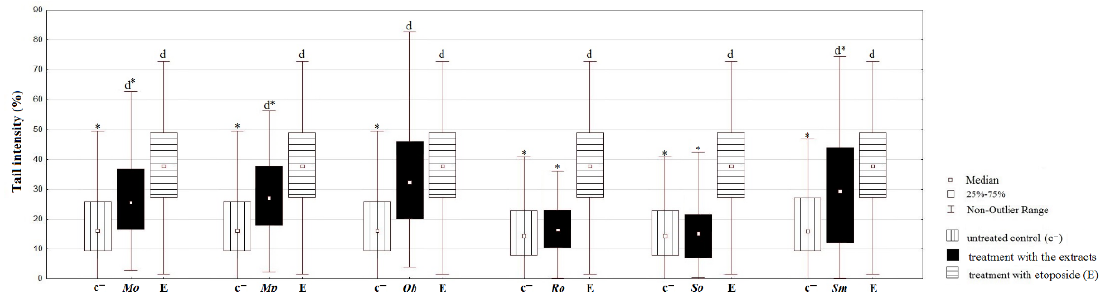
Figure 7. Comet assay performed on HCT-116 cell line with the ethanolic extracts at the concentration of 100 µg/mL and expressed as percentage of tail intensity. * p < 0.05—significantly lower DNA damage in comparison with etopo- side (E); d p < 0.05—statistically significant increase of DNA damage in comparison with the untreated control, c − .